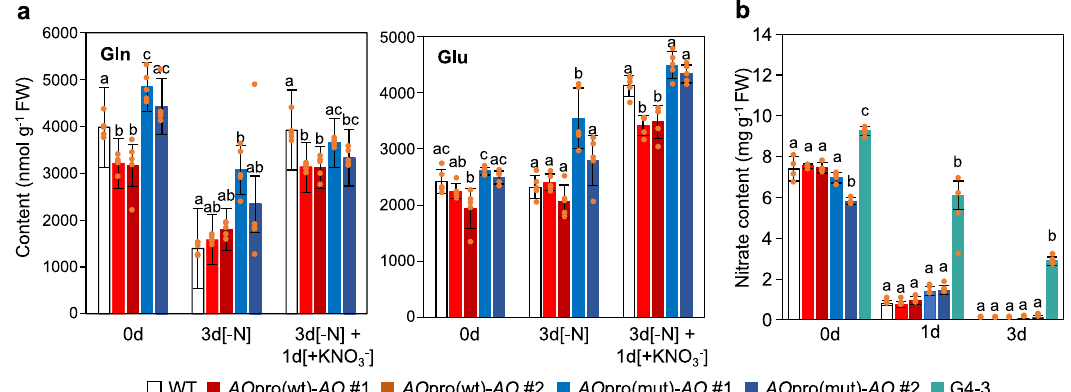
Fig. 8 Limited effects of erasing nitrate-induced AO expression on glutamine and glutamate contents and decreases in nitrate content. a Glutamine and glutamate contents in the shoots of WT, AO pro(wt)- AO , and AO pro(mut)- AO plants grown according to the scheme shown in Fig. 5a. Two independent lines (#1 and #2) of AO pro(wt)- AO and AO pro(mut)- AO plants were used. Data represent mean ± SD ( n = 5). b Decreases in the shoot nitrate content of wild-type, AO pro(wt)- AO , AO pro(mut)- AO , nlp7 and G'4-3 seedlings during the N starvation treatment. Seedlings were fi rst grown in the presence of KNO 3 and NH 4 NO 3 for 8 days and then grown in the absence of N sources for 0, 1, or 3 days. To grow G'4-3 ( nia1 nia2 double mutant) seedlings and other seedlings under the same nutrient condition, medium containing ammonium as N source was used in the pre-culture of all seedlings. Data represent mean ± SD ( n = 4). In ( a , b ), different lowercase letters indicate signi fi cant differences among various genotypes ( P < 0.05; Tukey ’ s HSD